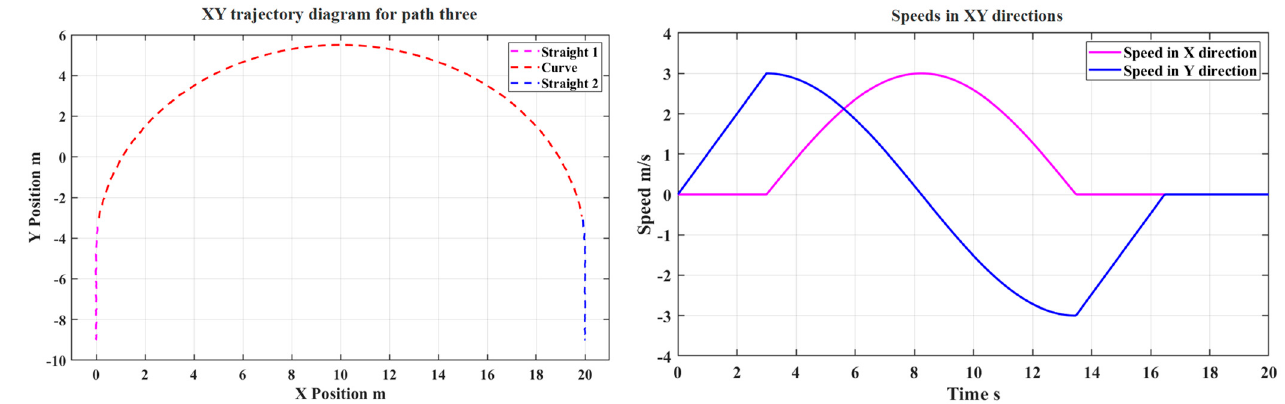
Figure 6. CLRV’s motion trajectory and speeds in the XY directions for desired path three. The initial position of the CLRV is (0, − 9). This path mainly consists of three parts: a section of straight motion with uniform acceleration, a turning curve with a radius of 10 m, and a section of straight motion with uniform deceleration.